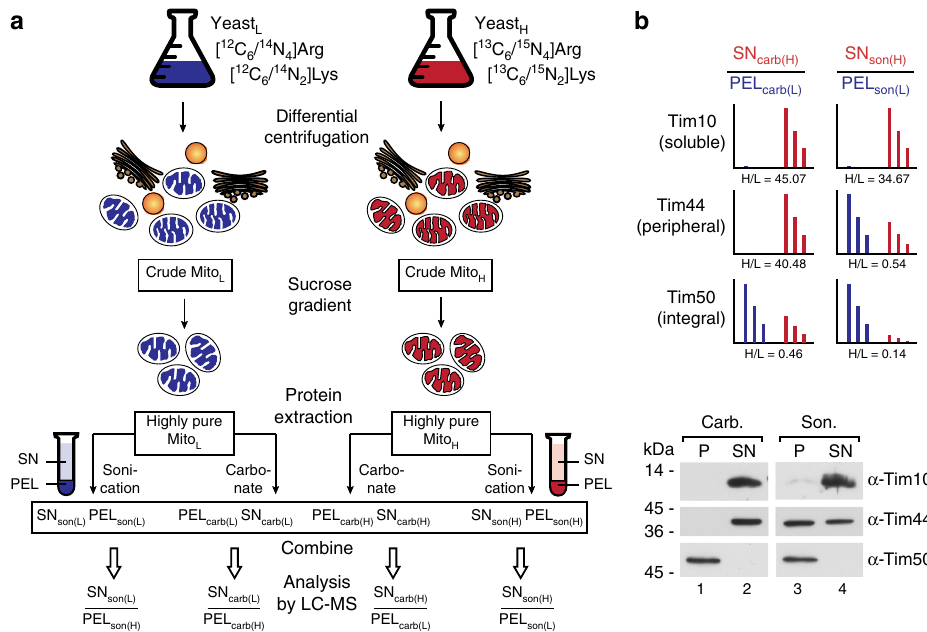
Fig. 1 Experimental design for global pro fi ling of peripheral membrane, integral membrane, and soluble proteins in highly pure yeast mitochondria. a Highly pure mitochondria were isolated from yeast cultures grown in the presence of either “ light ” (L) or “ heavy ” (H) amino acids (Arg, Lys). Protein extraction was performed based on sonication to separate membrane proteins (PEL son ) from soluble proteins (SN son ) or carbonate treatment, which results in a pellet containing integral membrane proteins (PEL carb ) and a supernatant with peripheral membrane and soluble proteins (SN carb ). Respective SN/PEL SILAC ratios were determined by LC-MS. carb , carbonate; son , sonication. b Exemplary SILAC results a for Tim proteins representing the three different